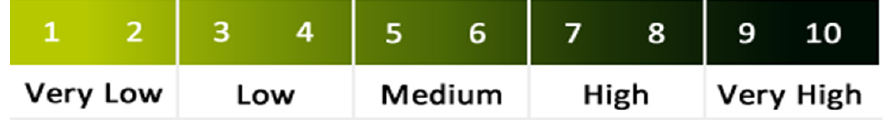
Figure 2. Linguistic scale for rating the importance of criteria and performance of alternatives.